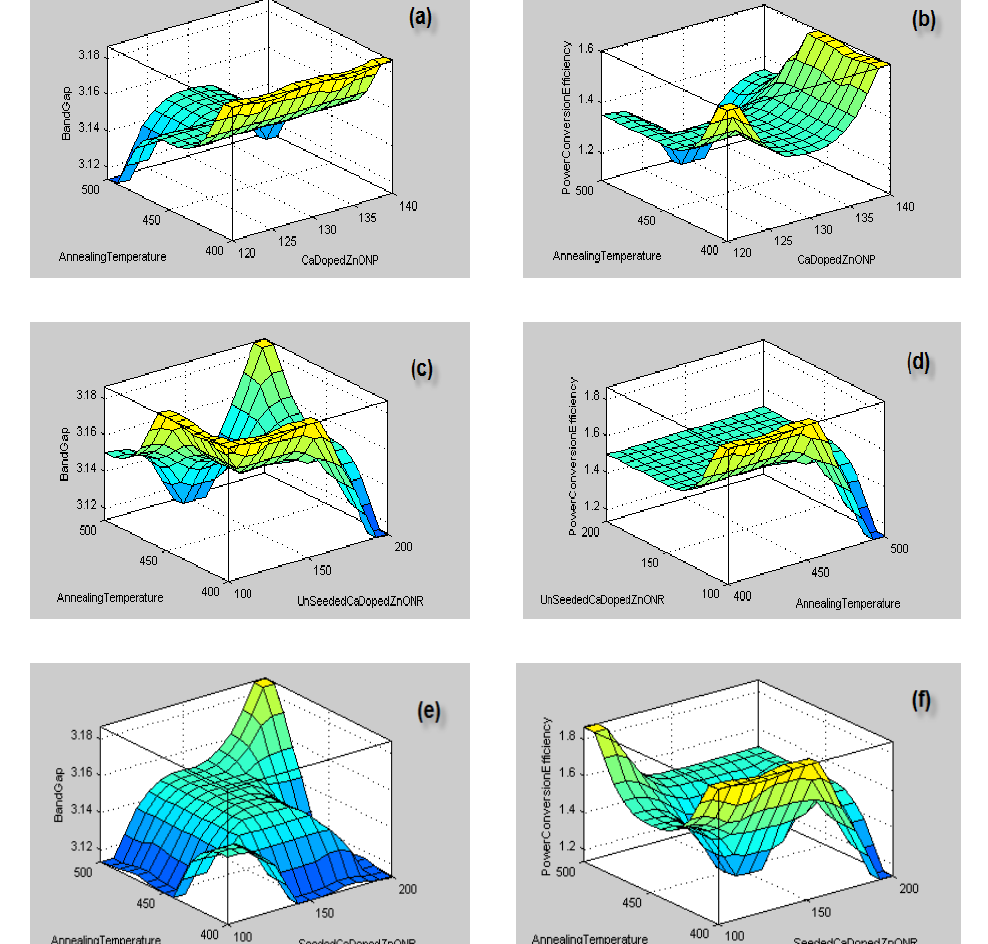
Figure 3. 3D graphs of band gap and power conversion efficiency and its effect on ( a , b ) Annealing temperature and Ca-doped ZnO NP; ( c , d ) Annealing temperature and unseeded Ca-doped ZnO NR; ( e , f ) Annealing temperature and seeded Ca-doped ZnO NR.